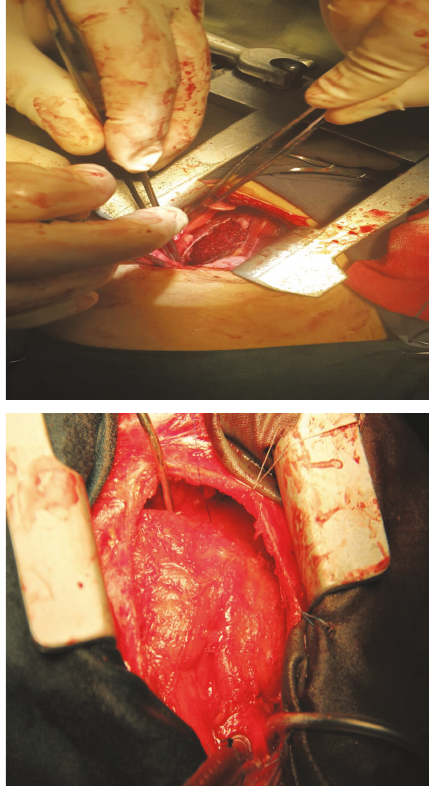
Figure 2: Thickening and inflammation of pericardium.